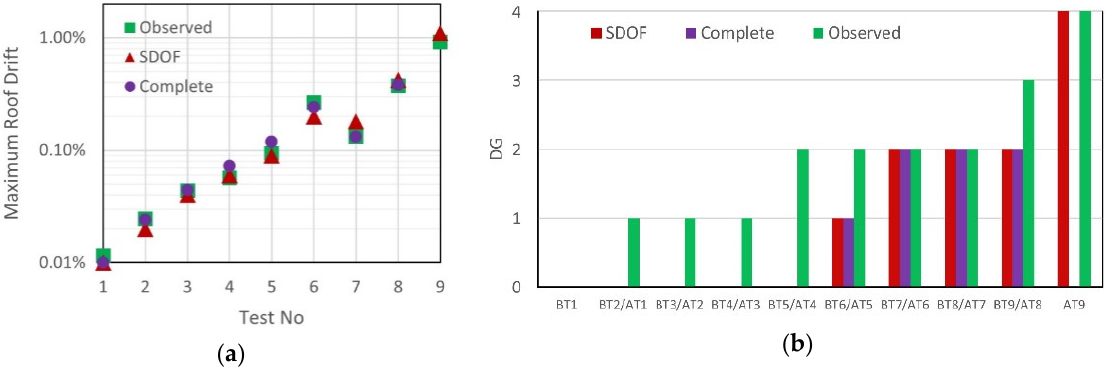
Figure 11. Comparison of numerical modelling results in terms of ( a ) the maximum roof drift ratios, ( b ) the damage estimations. BT: Before the test, AT: After the test.